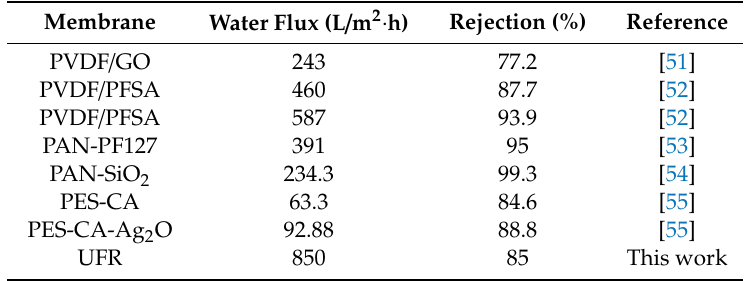
Table 1. Comparative water flux and rejection ratio of composite membranes.